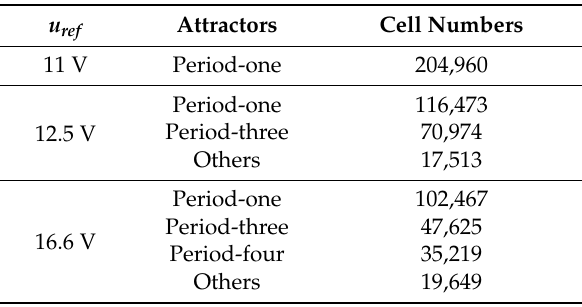
Table 2. Cell numbers and attractors of different u ref